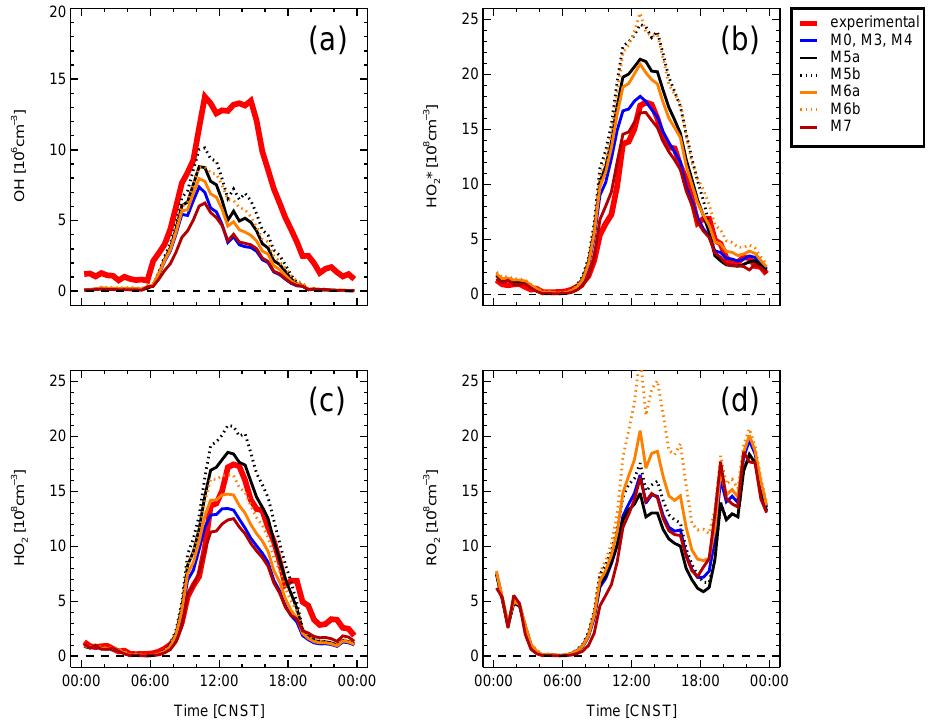
Fig. 12. Comparison of measured and modelled concentrations of OH (a) and HO ∗ 2 (b) , HO 2 (c) , and RO 2 (d) for six different mechanistic scenarios: M0, M3, M4, M5a, M5b, M6, M7. The results for each radical species are not distinguishable among the model runs M0, M3 and M4 (differences are within the thickness of the lines).